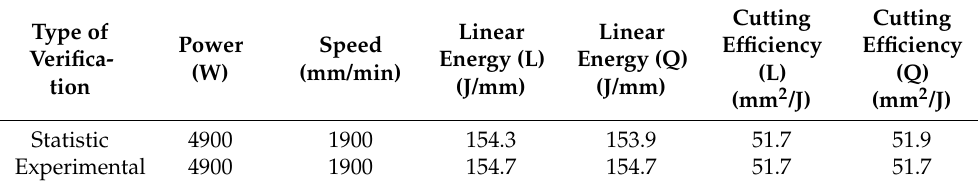
Table 14. Results